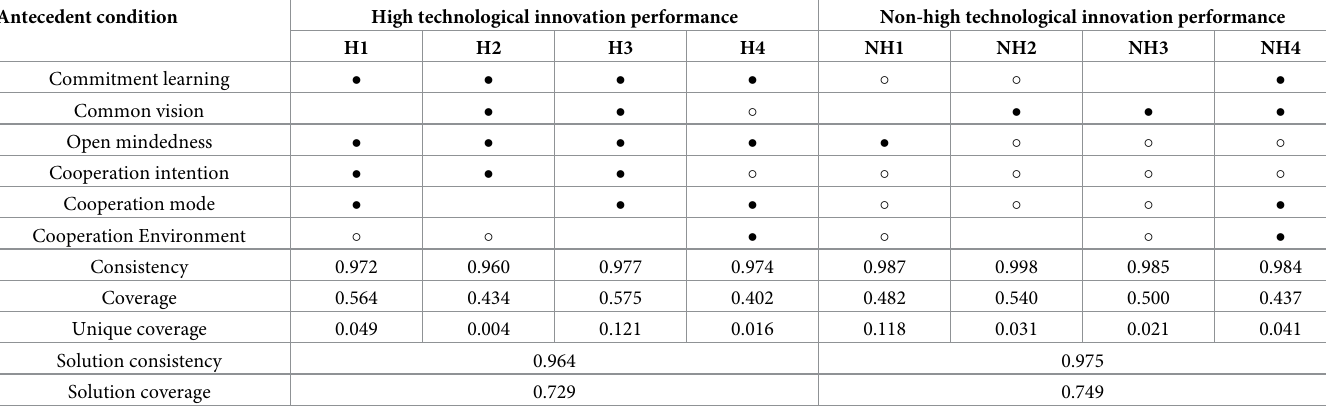
Table 5. Configurations of high technological innovation performance.